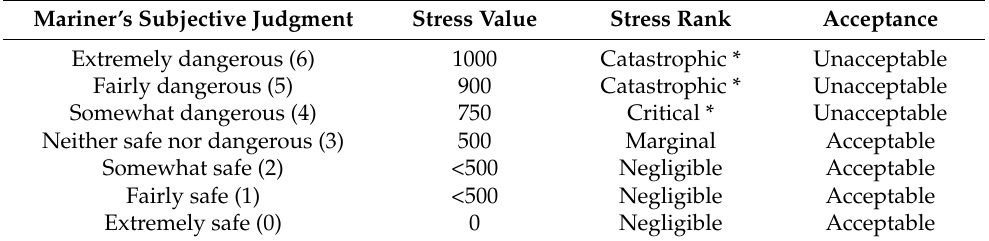
Table 1. Stress values and acceptance criteria [31]. Reprinted with permission from Young-Soo Park. Copyright